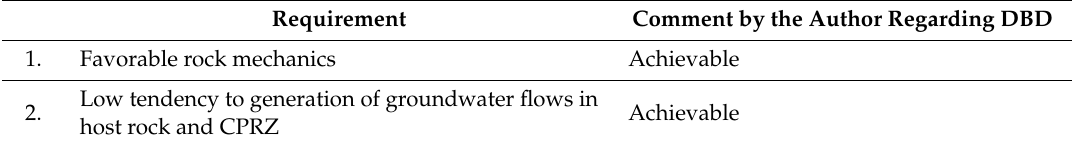
Table 2. Requirements of weighting group 2: Validation of containment.